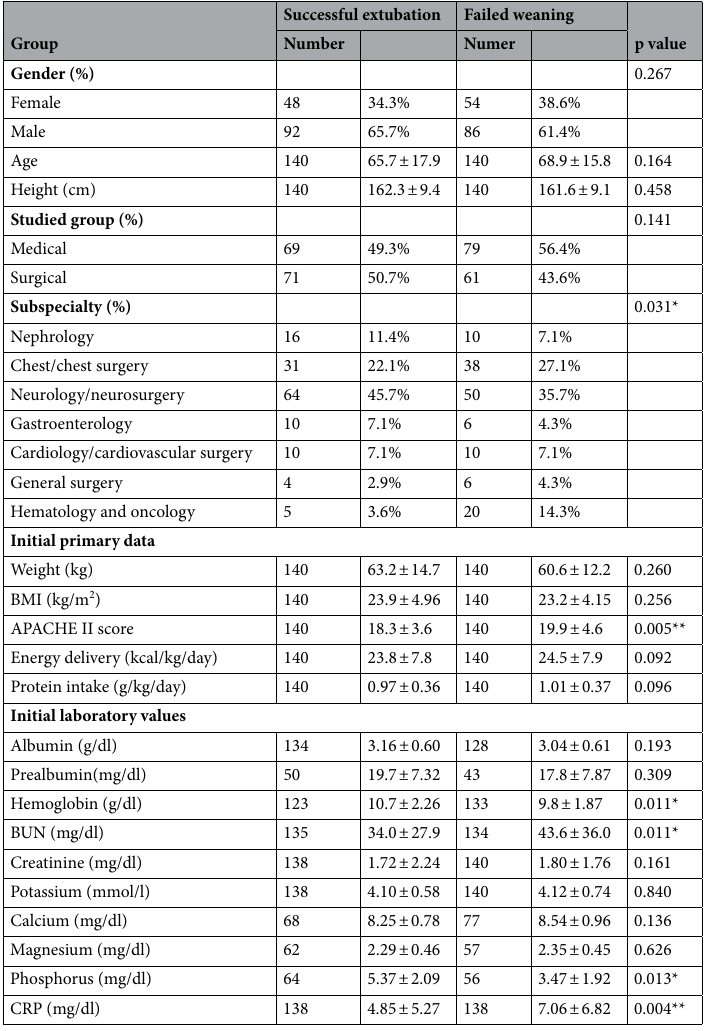
Table 1. Baseline characteristics of enrolled patients. Continuous data are expressed as mean ± SD and categorical data are expressed as n (%). The p values are from Pearson chi-square test for categorical variables and from independent t test for continuous variables. The p values are from the Mann–Whitney U test for laboratory data. *p values < 0.05 and **p values < 0.01 are considered statistically significant and extremely significant, respectively. BMI Body Mass Index, APACHE II score Acute physiology assessment and chronic health evaluation II score, BUN blood urea nitrogen, CRP high sensitivity C reactive